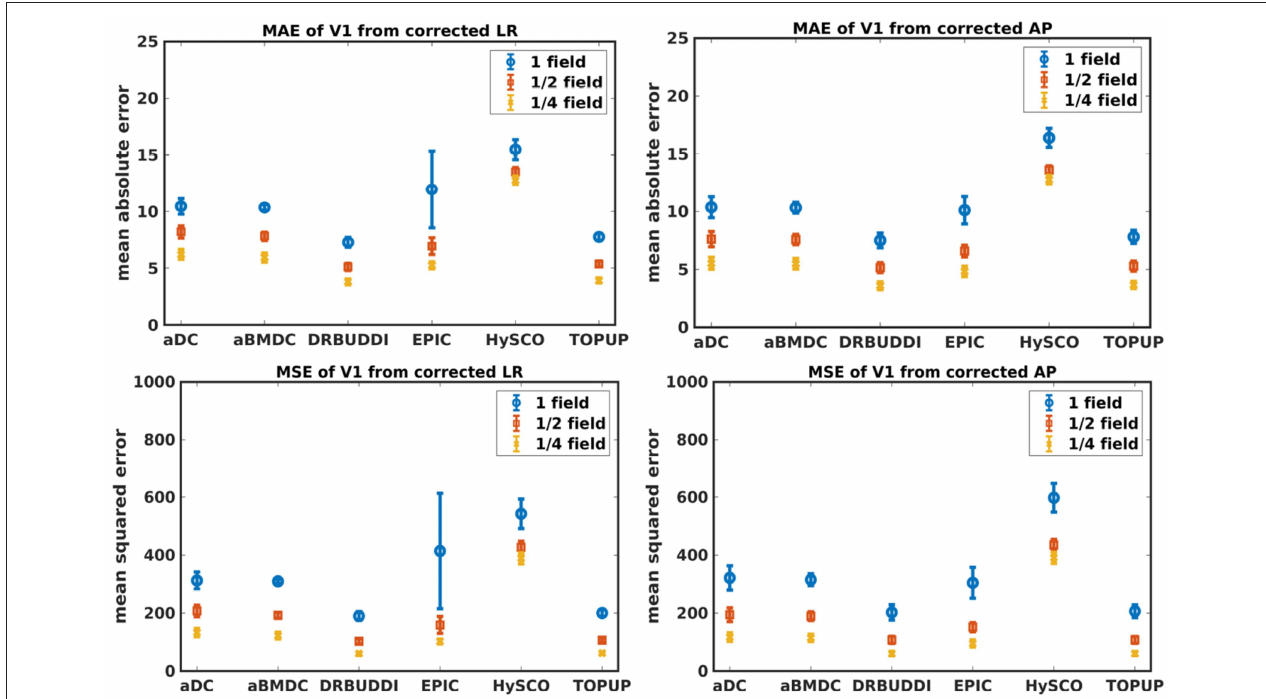
FIGURE 9 | MAE (Top) and MSE (Bottom) of principal eigenvectors for five simulated HCP subjects using the six methods. The error bars represent standard deviation over subjects. Correction was carried out for LRRL (Left) and APPA (Right) pairs, respectively. Three levels of susceptibility distortion were simulated. TABLE 4 | MAE and MSE of b 0 , FA, MD, principal eigenvalues and principal eigenvectors using the six methods. Tool aDC aBMDC DR-BUDDI EPIC HySCO Metric